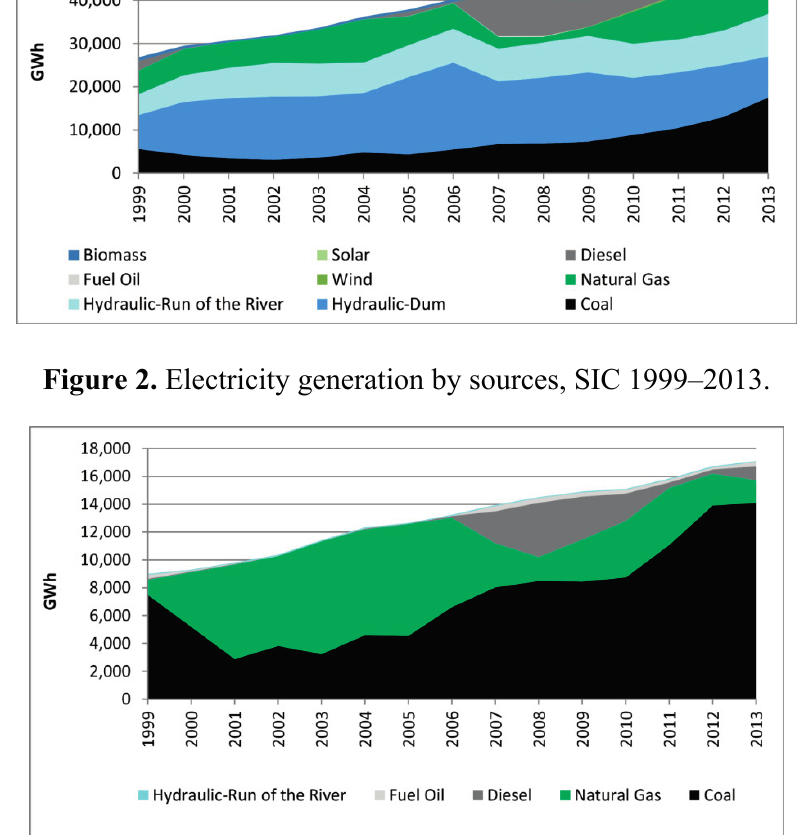
Figure 3. Electricity generation by sources, SING